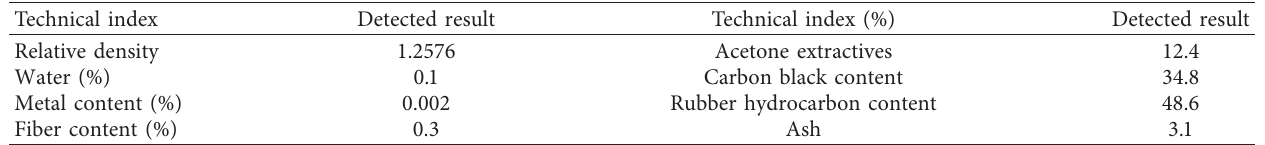
Table 3: 40-mesh crumb rubber performance